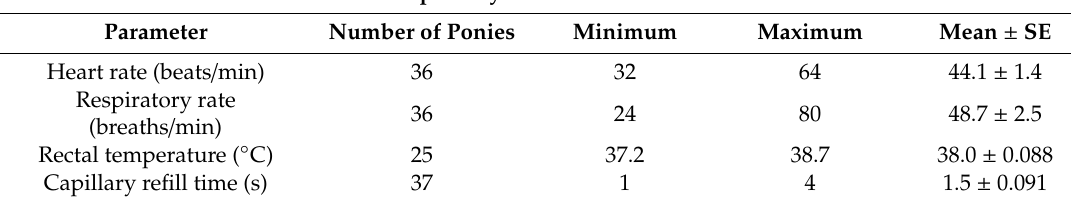
Table 2. Heart rate, respiratory rate, temperature, and capillary refill time (CRT). These datasets were normally distributed based on a p -value > 0.05 using Shapiro–Wilk’s test. Other pony health examination results are shown in Table 3. SE—standard